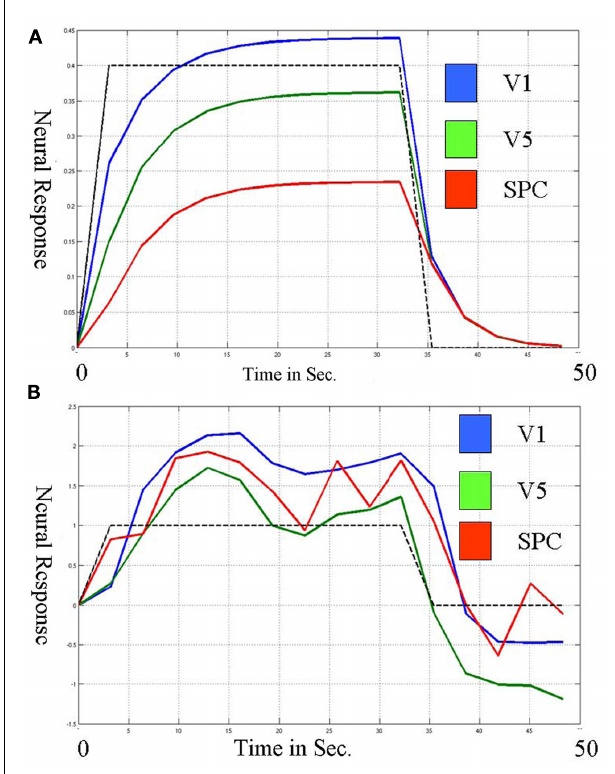
FIGURE 1 | Neural responses over a single block ( ∼ 30s.) in three regions during theAttention toVisual Motion task as estimated via deterministic (A) and stochastic (B) models. (A) Connectivity in the deterministic (DCM) model is seen in the slope of the block onset.The regionV1 (blue) increases first and most rapidly andV5 (green) increases with a similar slope.The region SPC (red) increases more slowly; its slope is less similar toV5 thanV5 is toV1, thus the connectivity fromV5 to SPC is less than that fromV1 toV5.This slope magnitude and slope similarity is the nature of the deterministic connectivity. (B) In contrast, the three regions respond similarly in the onset of the block for the stochastic model. The connectivity is in the covariance within the block.V1 andV5 are more connected thanV5 and SPC because their estimated responses are more correlated within the